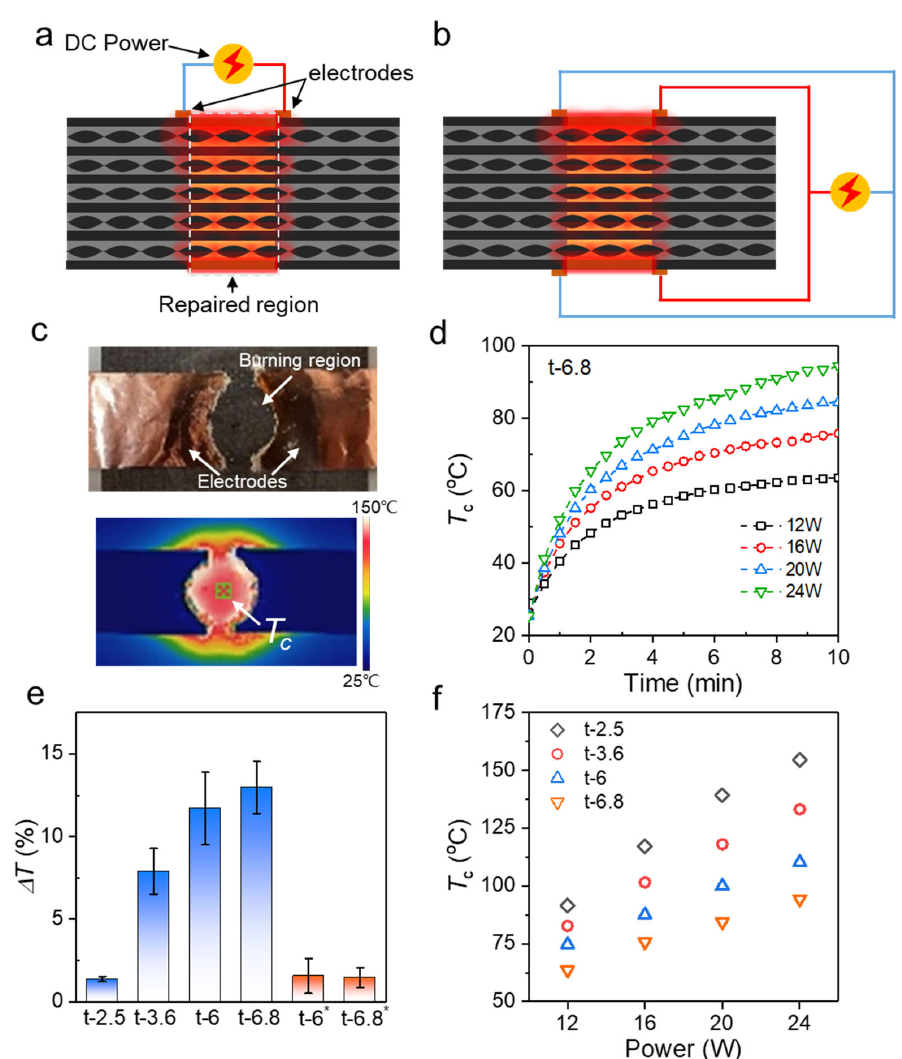
Figure 4. Thermal ablation repair. The electrodes are added on ( a ) the top or ( b ) both surfaces. ( c ) Electrode photos and corresponding thermal images when supplying power is 24 W. The green square denoting the center position where the temperature changes with heating time is shown in ( d ) for t-6.8. ( e ) Relative temperature difference ∆ T between the top and bottom surfaces for panels with different thicknesses. The blue columns denote that the electrodes are added on the top surface, while the red columns with the symbol * represent the electrodes are added on both surfaces. ( f ) The plateau temperature in ( d ) as a function of supply power for four